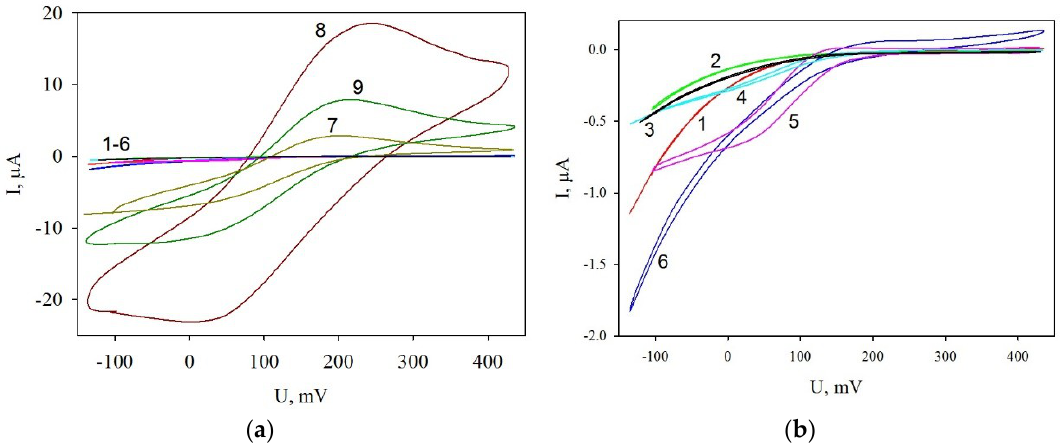
Figure 5. Cyclic voltammograms of modified electrodes: 1, a nonmodified electrode; 2, with PMCs, 3, GOx; 4, PMCs containing MWCNTs in the hollow and between polyelectrolyte layers; 5, PMCs containing MWCNTs between polyelectrolyte layers; 6, PMCs containing MWCNTs in the hollow; 7, PMCs with GOx; 8, MWCNTs; and 9, PMCs with GOx and MWCNTs in the hollow. Measurements were carried out with the addition of 5 mM HCF. For comparison, a shows all types of dependences, while b represents the zoom of curves 1–6.